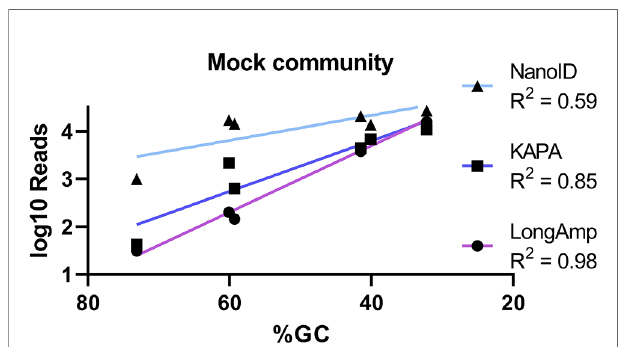
FIGURE 3 | Basic linear regression analysis used to correlate the GC content (%) of mock community skin genera in sequenced samples (x-axis) compared to the number of reads in the MinION ™ sequenced